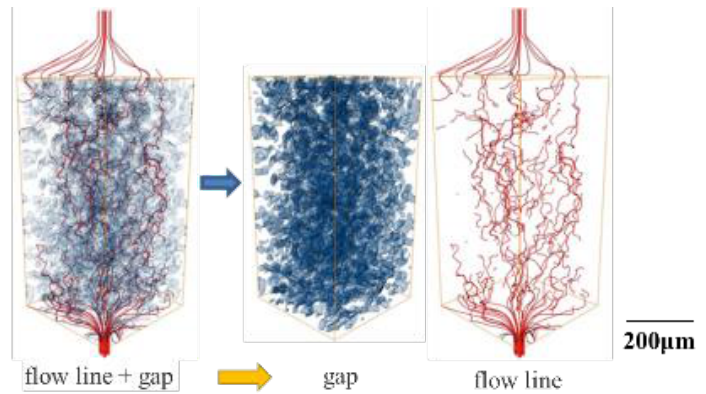
Figure 17. Seepage channel without